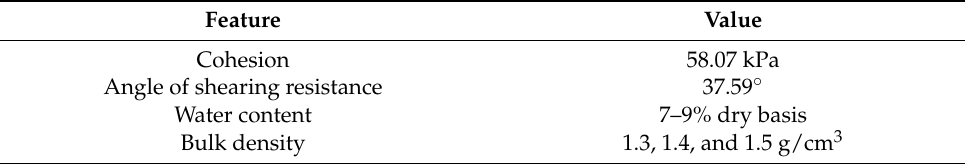
Table 1. Mechanical properties of sandy loam soil used in the